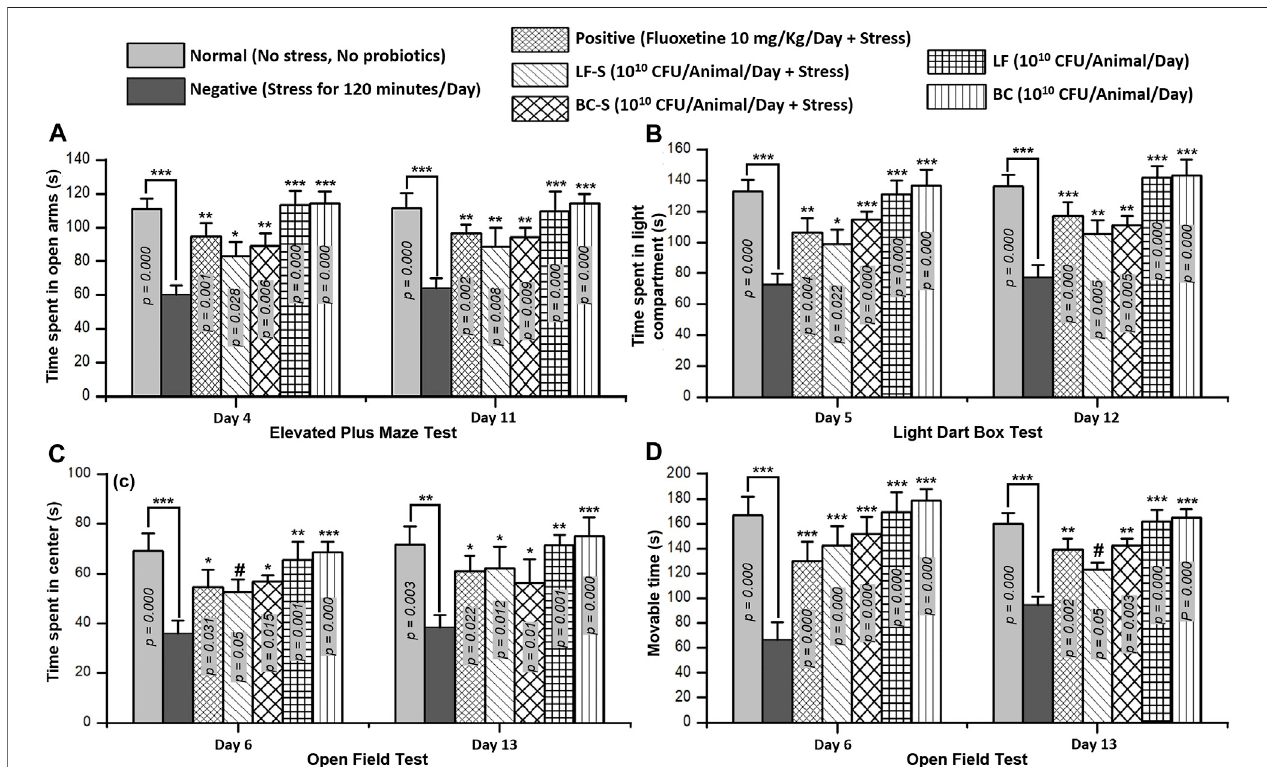
FIGURE1| Effectsof Lactobacillusfermentum NMCC-14 (10 10 CFU/day,p.o) and Bacillusclausii (10 10 CFU/day,p.o)inrestraint-stressedand normal mice in (A) elevated plus maze (EPM) test, (B) light dark box (LDB) test, and (C,D) open fi eld test (OFT). Compared to the negative group, Lactobacillus fermentum NMCC-14 (10 10 CFU/day, p.o) and Bacillus clausii (10 10 CFU/day, p.o) signi fi cantly ( n = 5/group) increased the time spent in the open arms of EPM and the time spent in the light compartment of LDB as well as the movable time and time spent in the center of OFT in acute and subacute restraint-stressed mice. Compared to the normal group,nosigni fi cant( p < 0.05)changeintheanimals ’ behavioringroupsBCandLFoccurred.Valuesexpressedaremean±standarderrortothemean(SEM).Notethat # p = 0.05, * p < 0.05, ** p < 0.01, and *** p < 0.001 versus the negative group by applying two-way